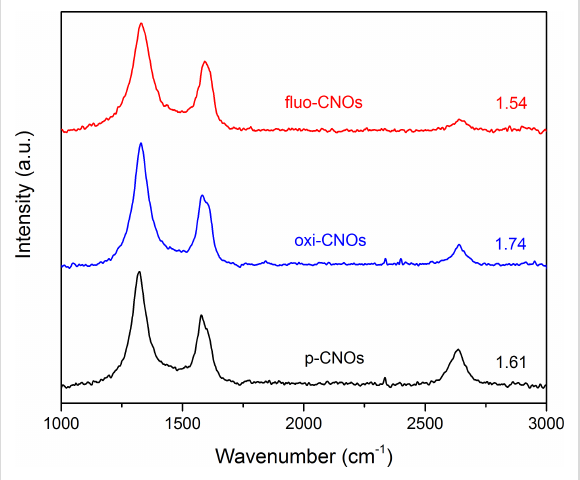
Figure 6: Cellular viability of HeLa cells treated with different concen- trations (1, 2, 5, 10 and 20 µg mL − 1 ) of fluo-CNOs for 12, 24, 28 and 72 h in DMEM (pH 7.4), revealed by the WST 1 assay. Cell viability (%) was evaluated for the CNO-treated samples against a non-treated control. As a positive control, the cells were incubated with 5% DMSO (showing a viability decrease of ca. 45%). Data are expressed as mean ± standard error as calculated from three separate